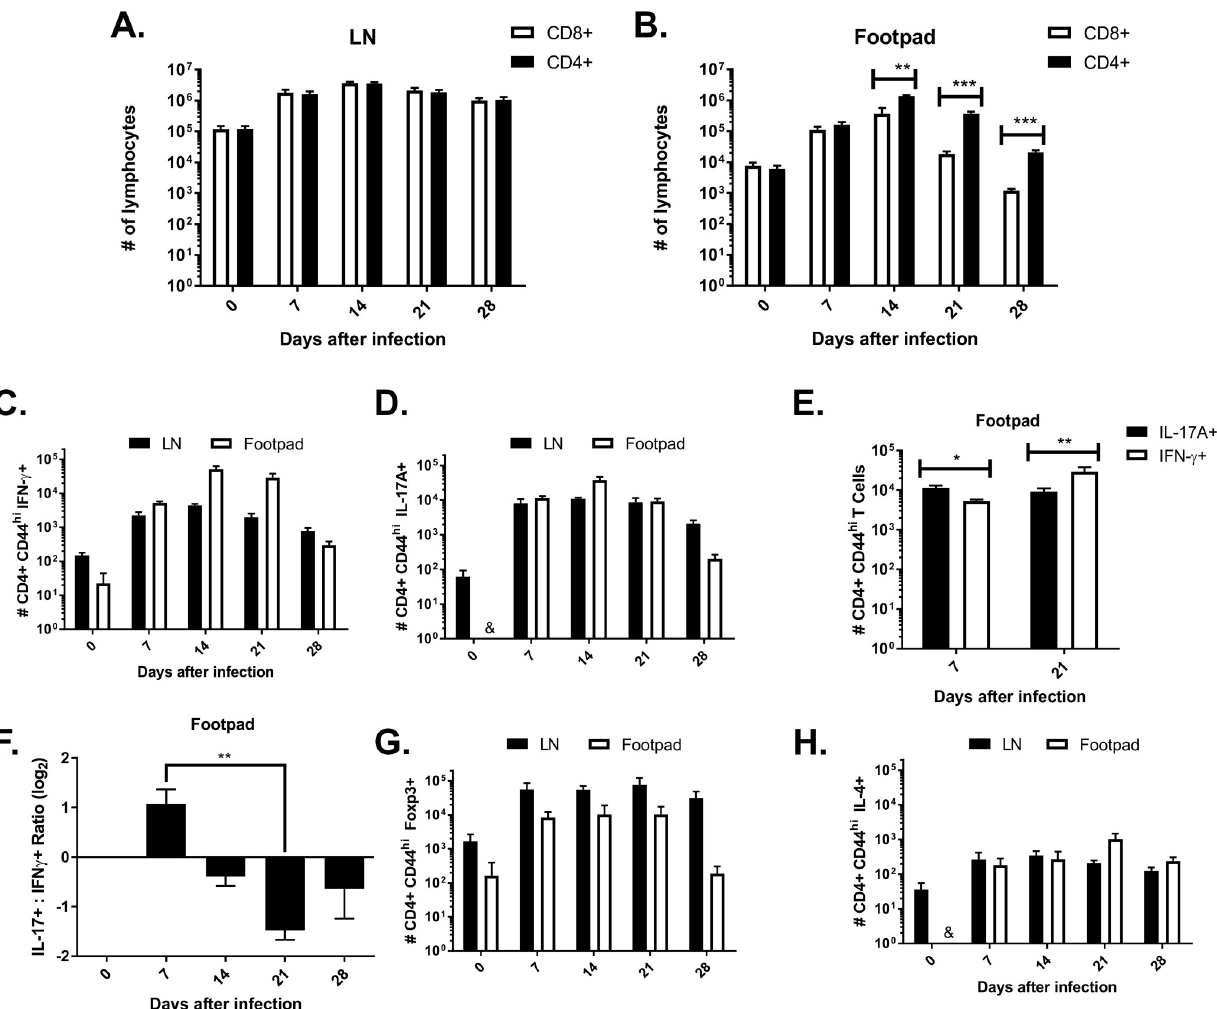
Fig 1. T lymphocyte subset quantification in footpad and dLN of mice infected with F . pedrosoi . CD4+ and CD8+ increase in popliteal lymph node (LN) after infection with 10 6 F . pedrosoi propagules containing hyphae and conidia ( A ). Quantification of T lymphocytes in the footpad showed high numbers of CD4+ compared to CD8+ T cell ( B ). Significant expansion of IFN- γ + ( C ), IL-17+ ( D ), and Foxp3+ ( G ) but not IL-4+ CD4+ T cells ( H ) was observed in dLN as well as in the site of infection during 28 days of infection with F . pedrosoi . In the footpad, the IL-17+ population was higher than IFN- γ + cells in the first 7 days of infection ( E ). The opposite occurs after 21 days, when the IFN- γ + population is higher than IL-17+ T cells ( F ), reversing the ratio between these populations. � P < 0.05, �� P < 0.01.